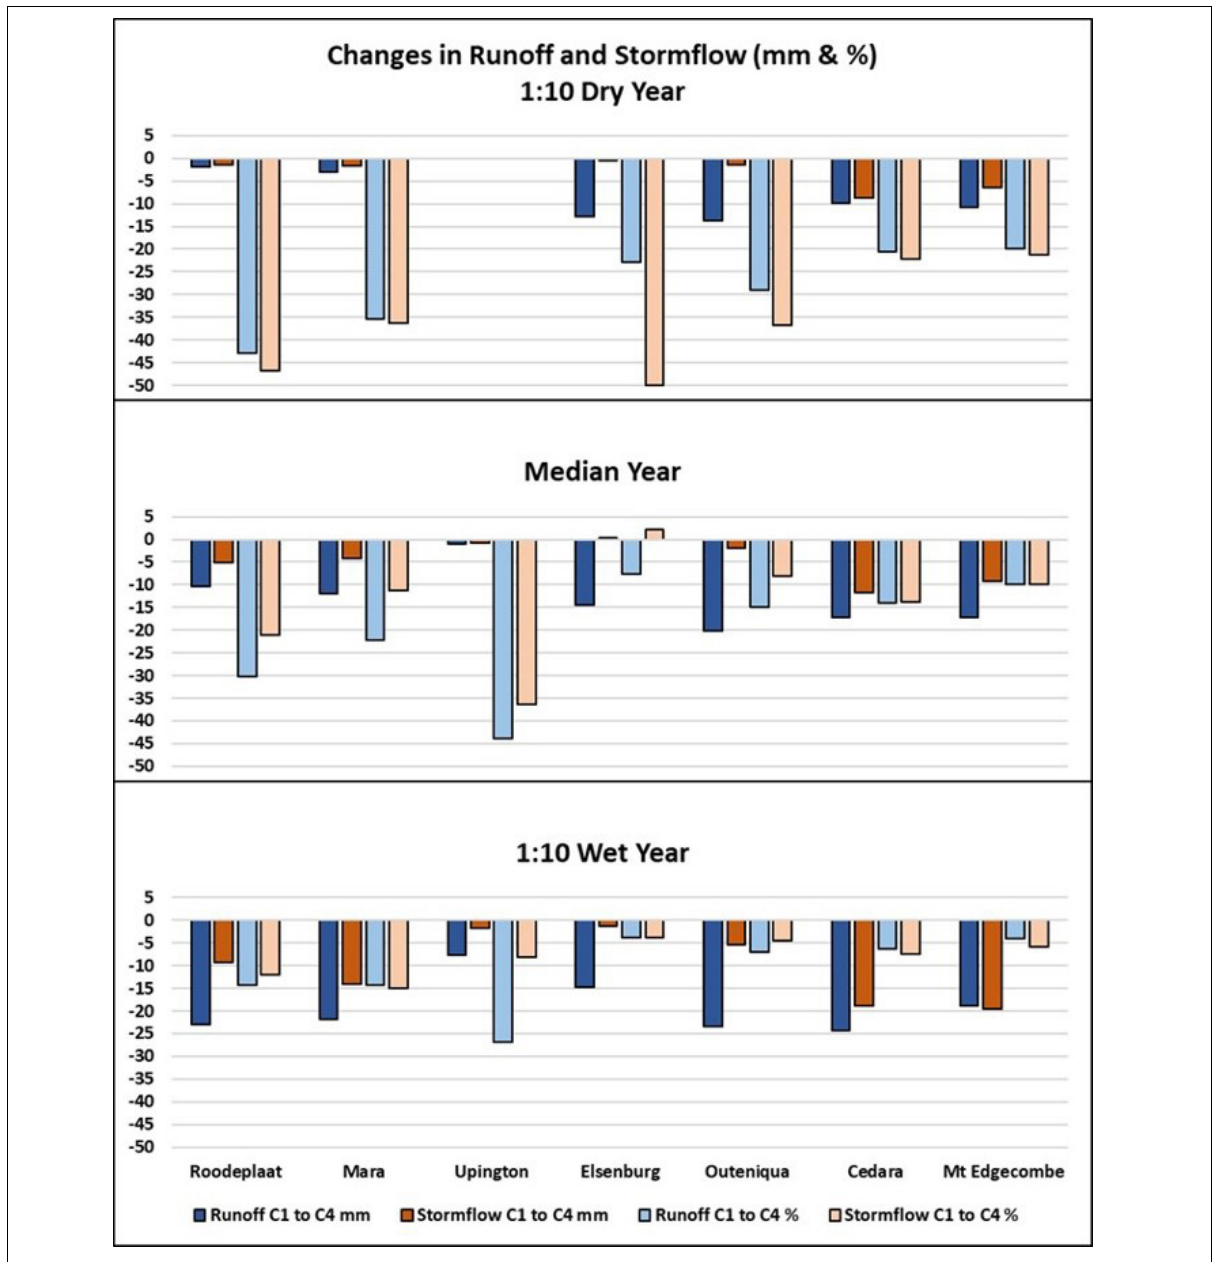
Figure 6: Changes in runoff and stormflow (mm and %) for carbon scenarios of 1% to 4% in a 1:10 dry year, a median year and a 1:10 wet year, for selected locations in South